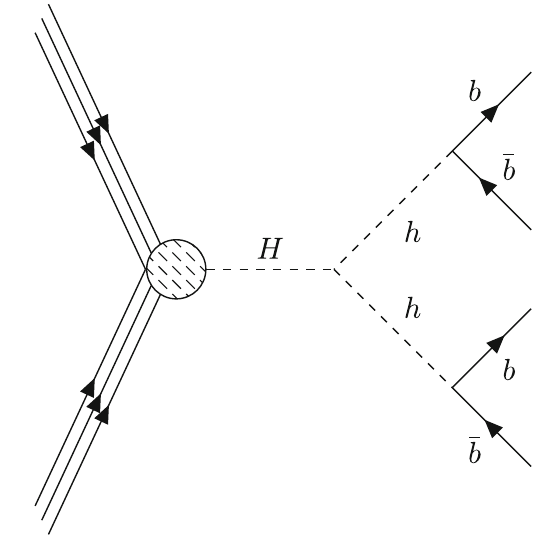
Fig. 1 The 2HDM process of interest, where the SM-like Higgs state ( m H = 125 GeV) produced from gluon-gluon fusion decays into a pair of lighter scalar Higgs states, hh , each in turn decaying into b ¯ b pairs giving a 4 b final